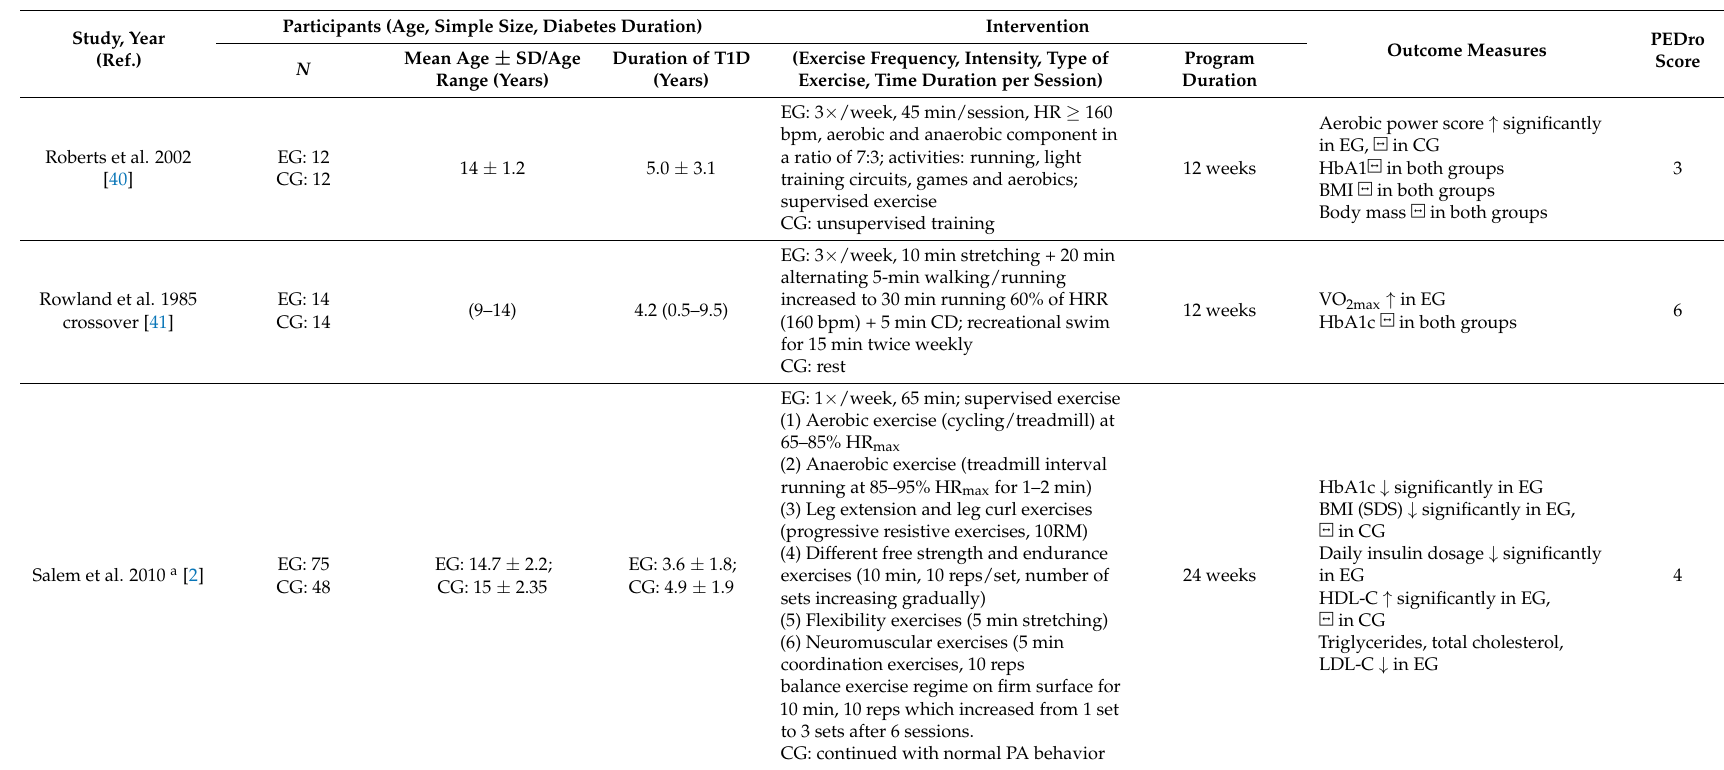
Table 1. Cont. Table 1. Characteristics of the included studies. Table 1. Characteristics of the included studies. Table 1. Characteristics of the included studies. Table 1. Characteristics of the included studies.